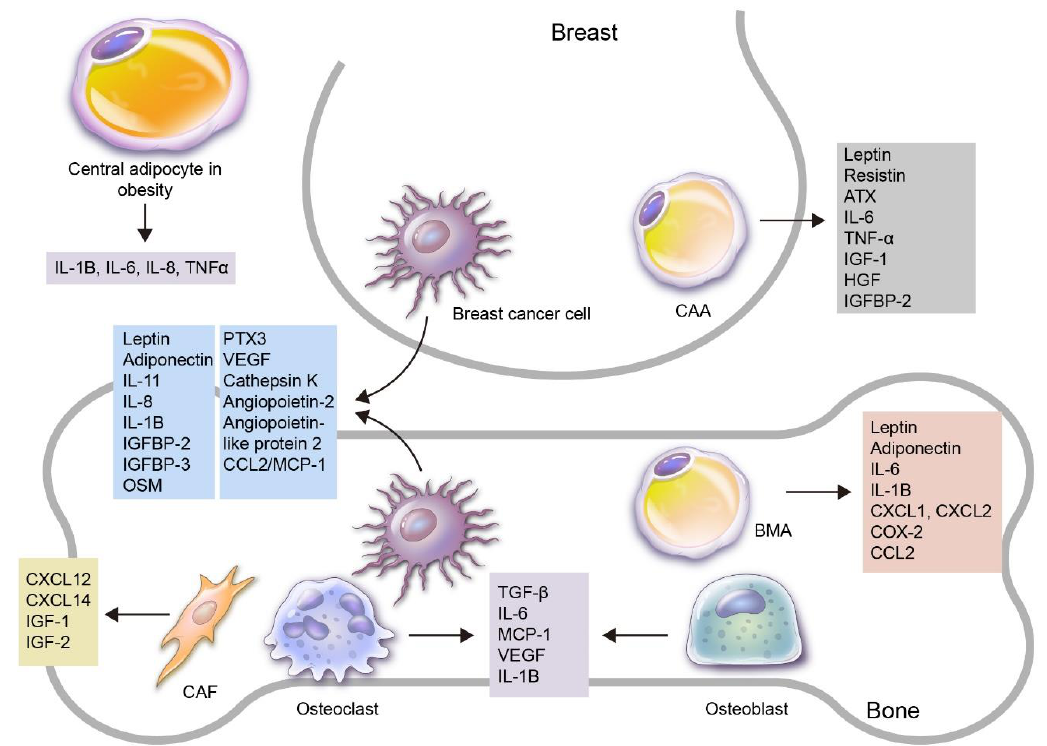
Figure 1. An overview of the roles of adipokines and adipocytes in the process of breast cancer bone metastasis. Various adipokines and adipocytes are involved in breast cancer development and progression to bone metastasis. Firstly, adipocytes can be subdivided into central and local adipocytes, and the former can a ff ect breast cancer with altered adipokine secretion, especially in obese patients. Local adipocytes can be further subdivided into cancer-associated adipocytes (CAAs) in the breast and bone marrow adipocytes (BMAs) in the bone. Adipokines can be secreted by various kinds of cells: breast cancer cells secrete leptin, adiponectin, IL-1B, IL-8, IL-11, IGFBP2, IGFBP3, OSM, PTX3, VEGF, cathepsin K, angiopoietin-2, angiopoietin-like protein2 and CCL2 / MCP-1, which are involved in breast cancer bone metastasis; CAAs secrete leptin, resistin, ATX, IL-6, TNF- α , IGF-1, HGF and IGFBP-2, which are involved in breast cancer progression; BMAs secrete leptin, adiponectin, IL-1B, IL-6, CXCL1, CXCL2, COX-2 and CCL2; bone stromal cells such as osteoclasts and osteoblasts secrete TGF- β , IL-6, MCP-1, VEGF, IL-1B and cathepsin K, which contribute to breast cancer bone metastasis. In addition, cancer-associated fibroblasts (CAFs) secrete CXCL12, CXCL14, IGF-1 and